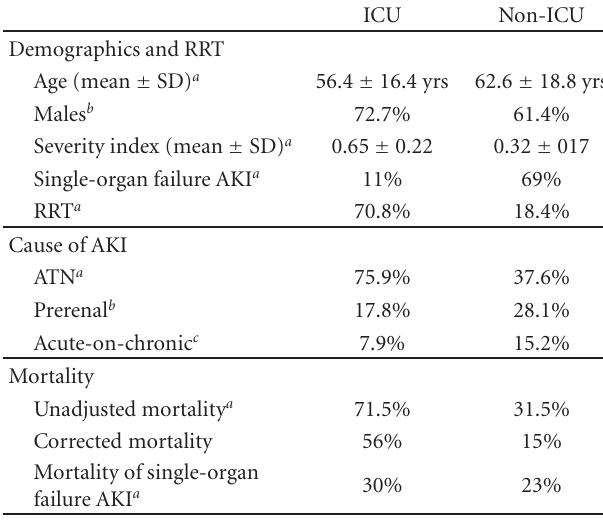
Table 2: Demographics and AKI outcomes in ICU compared to non-ICU (Madrid Acute Renal Failure Study Group)